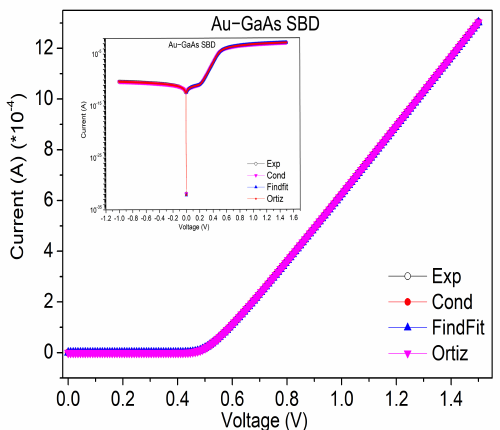
Figure 2. Experimental data and numerical characteristics obtained via the three methods for the Au-GaAs-based SBD. The inset figure shows the semi-log scale for these